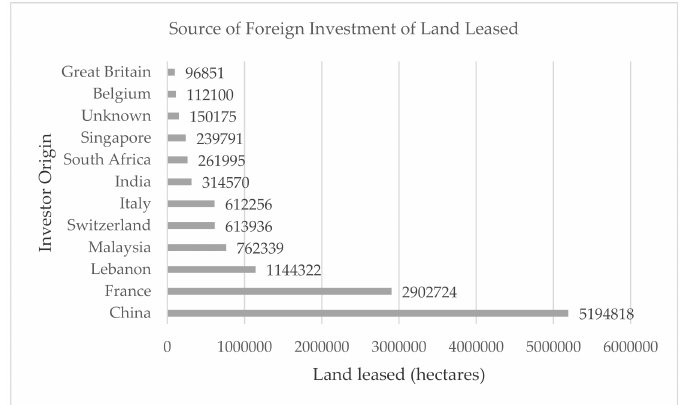
Figure 3. Source of foreign land investment in Gabon. (Note: A few changes were made to adjust for the age of the data—after 2011, OLAM Bois sold their forest concessions to Chinese KHLL [3], this was updated in our dataset acquired from GFW. We did not verify the accuracy of every deal listed in GFW’s